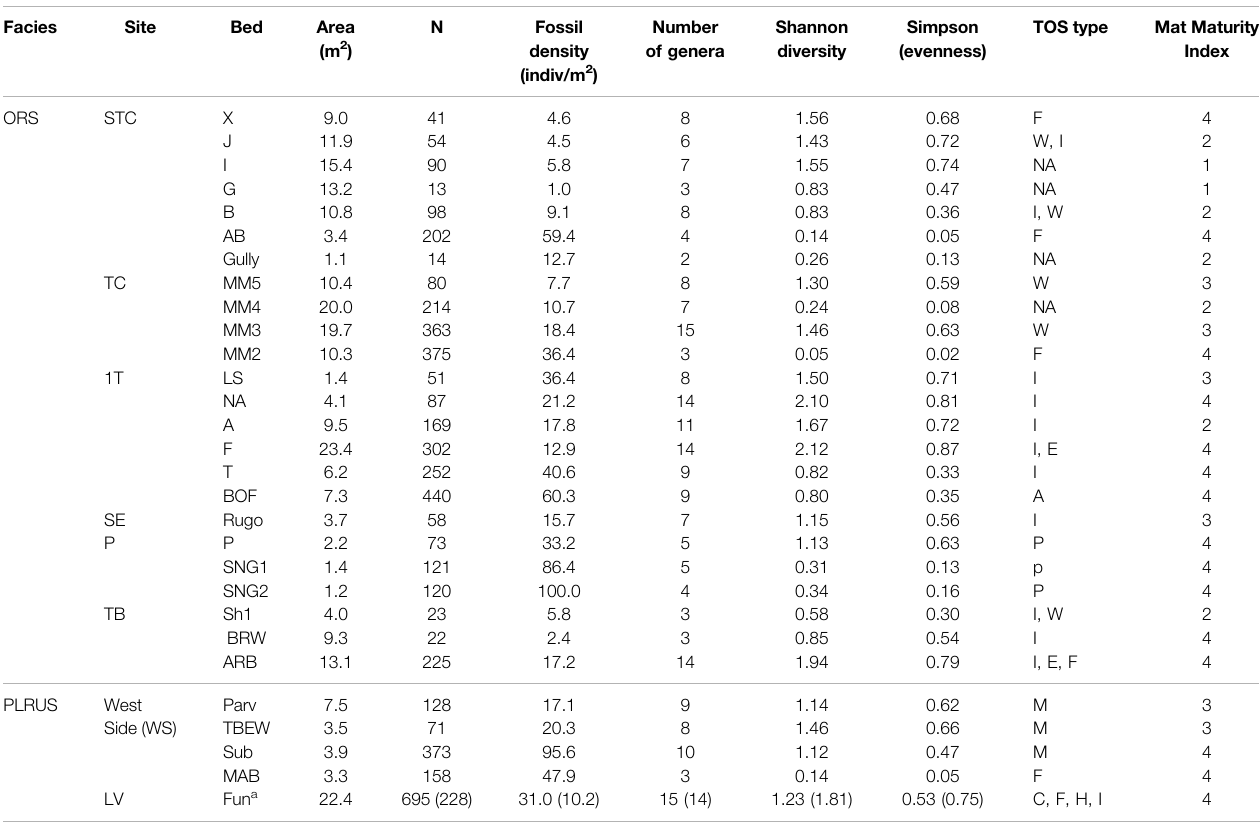
TABLE 2 | Bed data for taxa and mats. N is the number of discrete body fossils. Dominant TOS type indicated by M micropucker, E elephant skin, W weave, C clotted, F foam, H hair, I complex irregular, F Funisia , A algae and P Plexus. NA is no visible mat structure. Beds with more than one type of TOS are indicated by the appropriate combination of letters. Mat Maturity Index is based on rankings from Table 1 . Within each site, beds are listed in stratigraphic order with the younger at the top. The stratigraphic relationship between sites is not known.